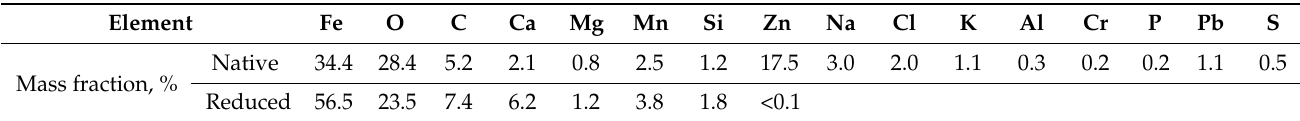
Table 1. Elemental composition of the native and reduced dust.